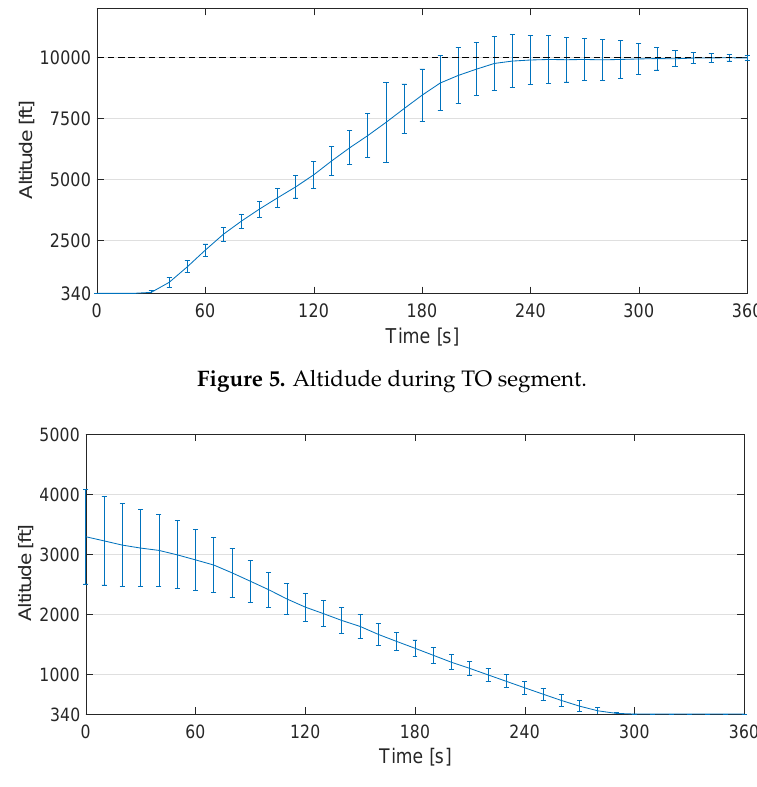
Figure 6. Altitude during LA